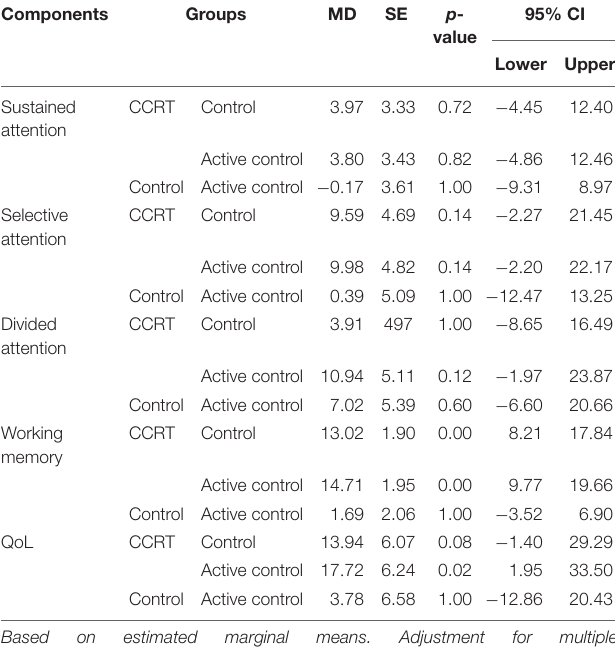
TABLE 3 | Summary of post hoc analysis (Bonferroni